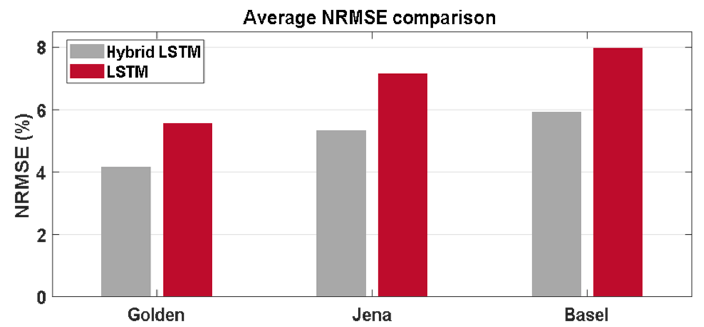
Figure 9. Bar charts comparing the average NRMSEs for the hybrid and Conventional LSTM models.